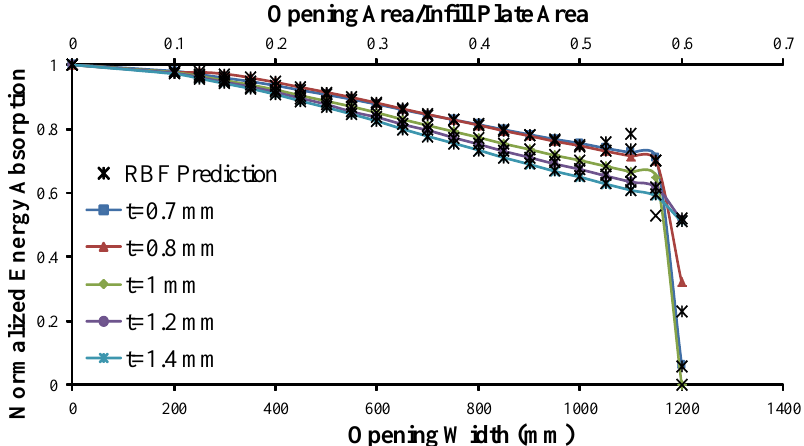
Figure 10. Real and predicted normalized absorbed energy values versus the various A o /A s